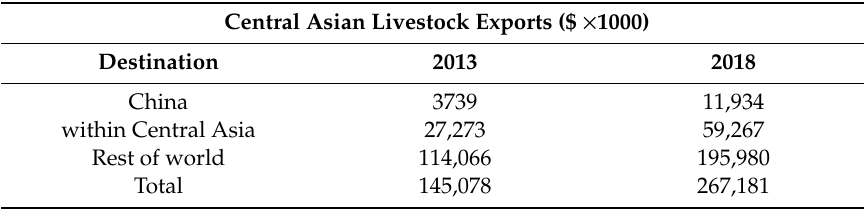
Table 9. Central Asian livestock exports, 2013–2018